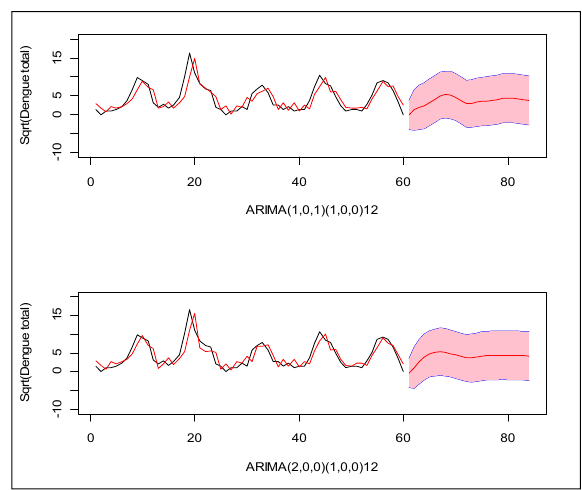
Figure 3. Two seasonal ARIMA models for the monthly number of dengue cases during years 2005–2009 in Zone-5 of Dhaka City Corporation, Dhaka, Bangladesh. X-axis indicates the index of the months, and Y-axis indicates the total number of dengue cases in square root scale. The black line is the observed cases and the red line is the modeled cases. The red line with pink region indicates the forecast of the next 20 months with 95% confidence band for prediction.